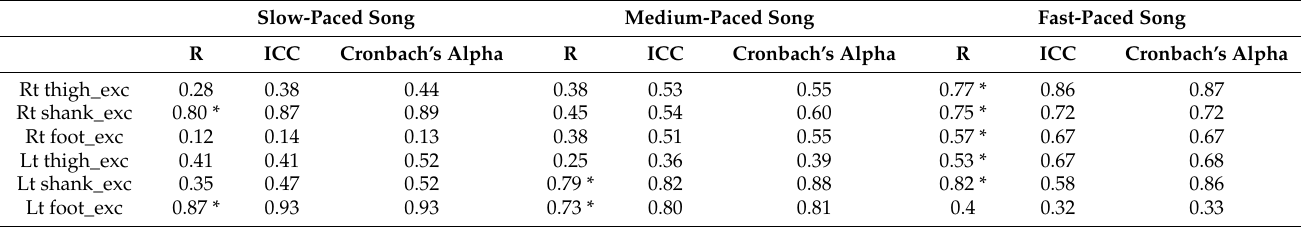
Table 3. Correlations between each song pace and segment angle excursions. Slow-Paced Song Medium-Paced